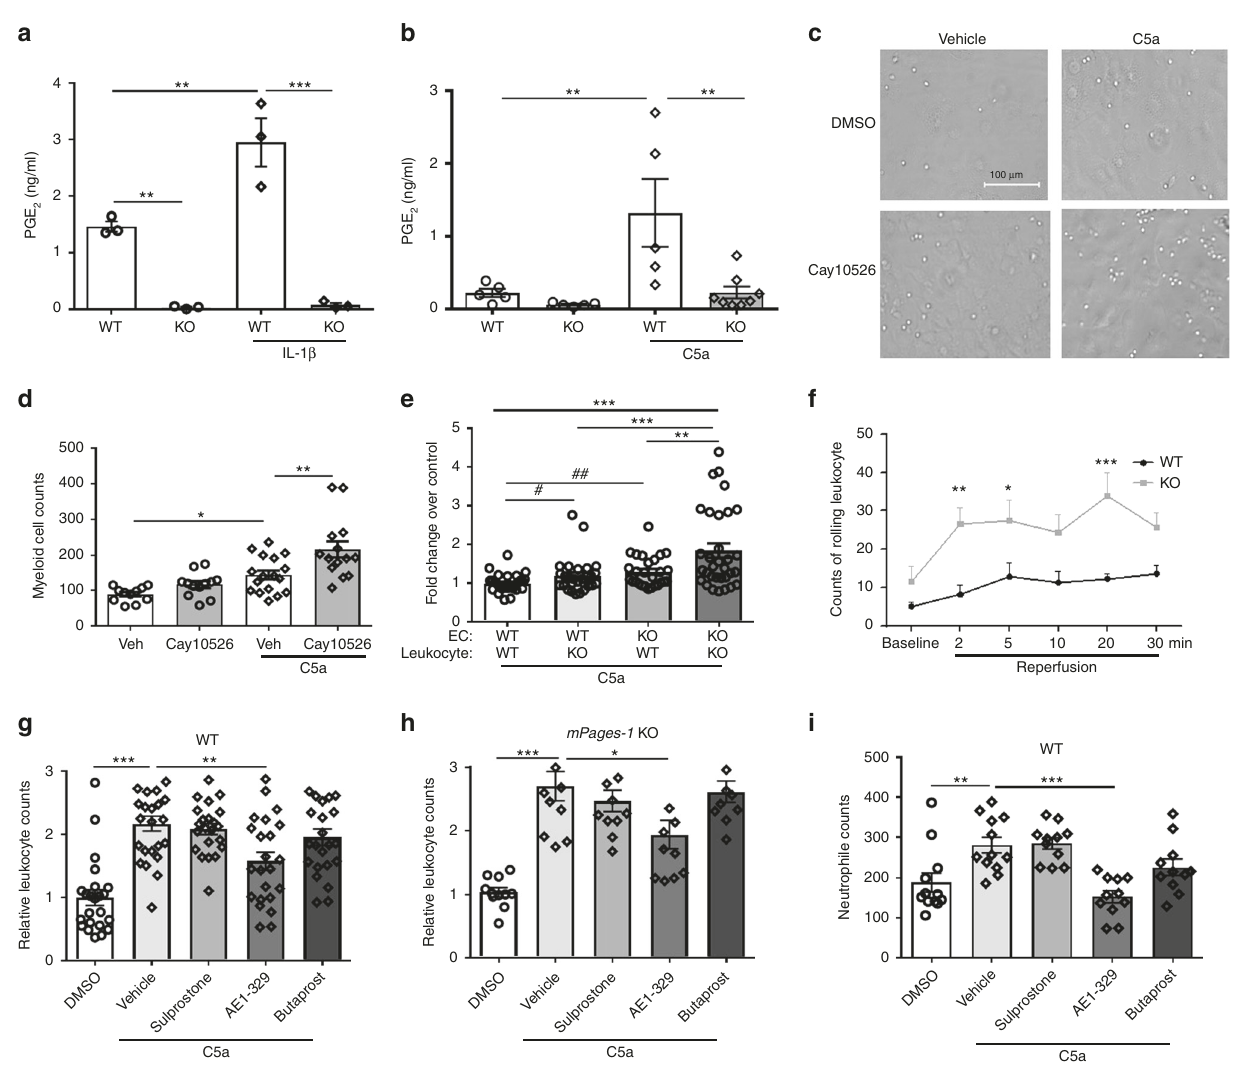
Fig. 5 mPGES-1 derived PGE 2 and EP4 activation limit leukocyte-EC interactions. PGE 2 levels were measured for culture supernatant of mouse ( mPges-1 WT/KO) lung endothelial cells (ECs) ( a ) and peritoneal myeloid cells ( b ). Cells were treated with 10 ng/ml IL-1 β for 12 h ( a ) or with 100 nM C5a for 30 min ( b ). Effect of mPGES-1 inhibition on cell adhesion was analyzed. WT ECs were treated with 10 μ M Cay10526 for 12 h before peritoneal myeloid cells were applied, and cell adhesion was quanti fi ed in absence or presence of 100 nM C5a. Representative photos of cell adhesion for each treatment condition ( c ) and the quantitative results ( d ) were shown. Adhesion of blood leukocytes to ECs was determined in vitro in presence of 100 nM C5a ( e ). The fold change of adherent cells over the number for WT leukocyte to WT EC was presented, with cell genotype labeled below each column. Leukocyte – endothelial cell interactions were videotaped by intravital microscopy during hindlimb I/R, and rolling cells were counted prior to and after femoral artery ligation and reperfusion at indicated time points ( f ), as detailed in the Methods. Effects of agonists for EP1/3 (Sulprostone), EP2 (Butaprost), and EP4 (AE1-329), each at 1 μ M, on in vitro blood leukocyte adhesion to WT ( g ) or mPges-1 KO ( h ) EC monolayer were examined in presence of 100 nM C5a. Adhesion of puri fi ed blood neutrophils was similarly examined ( i ). One-way ANOVA with Tukey ’ s multiple comparison tests ( a , n = 3; e , n = 29, 28, 27, 32; g , n = 23, 24, 22, 23, 23; h , n = 11, 11, 11, 11, 10; i , n = 12, 12, 11, 11, 11) or Bonferroni ’ s multiple comparison tests ( b , n = 5, 5, 5, 8; d , n = 11, 12, 17, 14). Two-way ANOVA with Bonferroni ’ s tests ( f , n = 6) and unpaired Student ’ s t test ( e , n = 29, 28, 27, 32, # p = 0.045; ## p = 0.0011). Error bar indicates